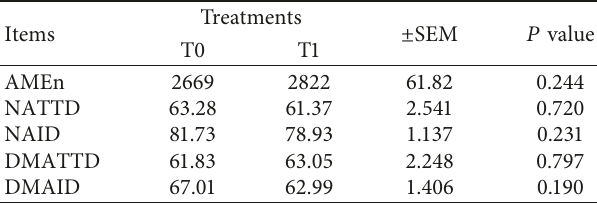
Table 3: Effect of the mixed powder of leaves of plants with medicinal properties on nutrient digestibility in